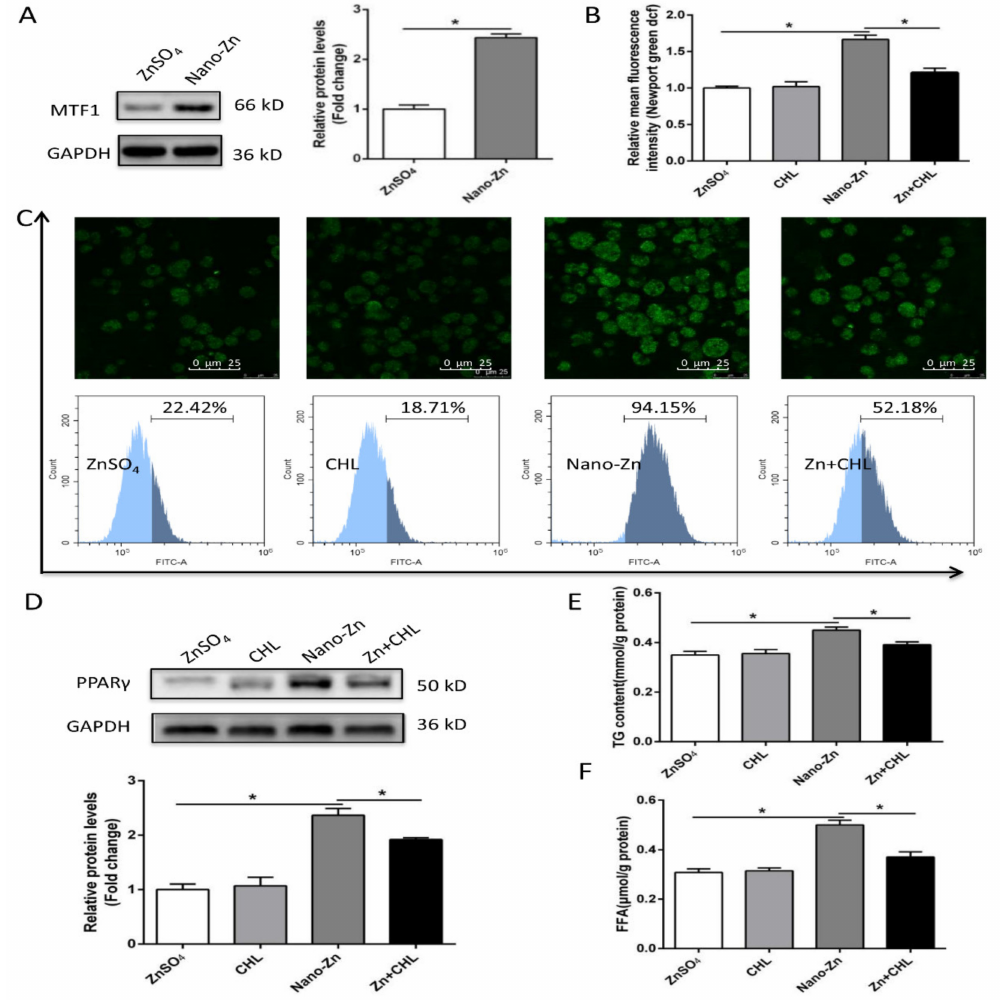
Figure 5. Nano-Zn-induced up-regulation of PPAR γ protein levels and TG content is related to nano-Zn absorption. ( A ) Protein levels of MTF1 after 40 µ M nano-Zn incubation for 24 h. ( B ) Free Zn 2 + was quantified by calculating the FL1 (green) mean fluorescence intensity of intestinal epithelial cells incubated for 24 h in 40 µ M nano-Zn with 10 µ g / mL CHL pretreatment for 2 h. ( C ) Representative confocal microscopy stained with Zn 2 + fluorescent probe (Newport Green DCF), and the presence of DCF-stained Zn 2 + was demonstrated by flow cytometric analysis of green (FL1) fluorescence intensity. The primary intestinal epithelial cells from P. fulvidraco were incubated for 24 h in ZnSO 4 or 40 µ M nano-Zn containing medium with or without 10 µ g / mL CHL pretreatment for 2 h. ( D ) Protein levels of PPAR γ of intestinal epithelial cells incubated for 24 h in control or 40 µ M nano-Zn containing medium with or without 10 µ g / mL CHL pretreatment for 2 h. ( E ) TG content after 24 h treatments. ( F ) Free fatty acid content after 24 h treatments. Values indicate means ± SEMs, n = 3–6. Asterisks ( ∗ ) indicate significant di ff erences between two groups ( p < 0.05, n = 3). CHL, chlorpromazine. To further confirm that nano-Zn-induced changes in TG and FFA were attributable to the change in + (cid:48) (cid:48) intracellular free Zn 2 levels, we used N,N,N ,N -tetrakis (2-pyridylmethyl) ethylenediamine